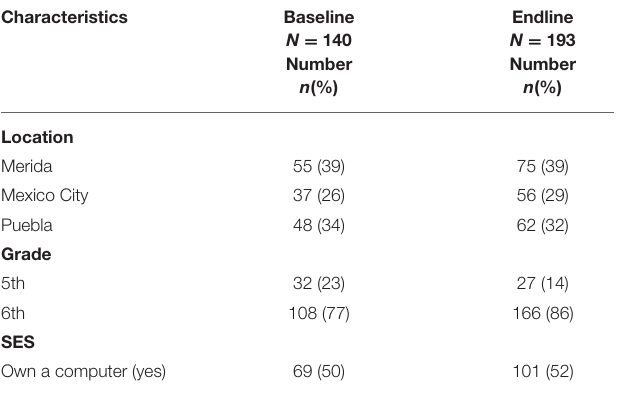
TABLE 2 | Study sample by location, grade and SES at baseline and endline. Characteristics